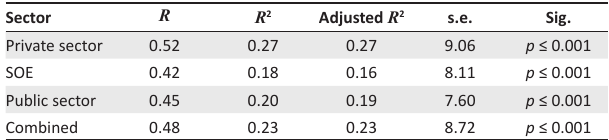
TABLE 5: Model summary of regression analysis – Variance explained in organisational commitment by human resource practices.